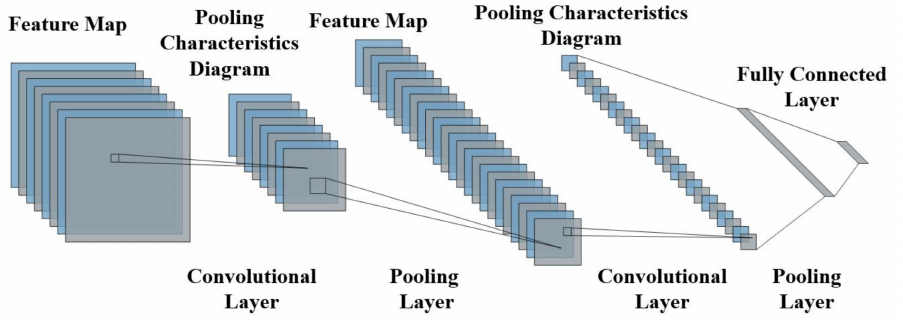
Figure 1. Diagram of convolutional neural